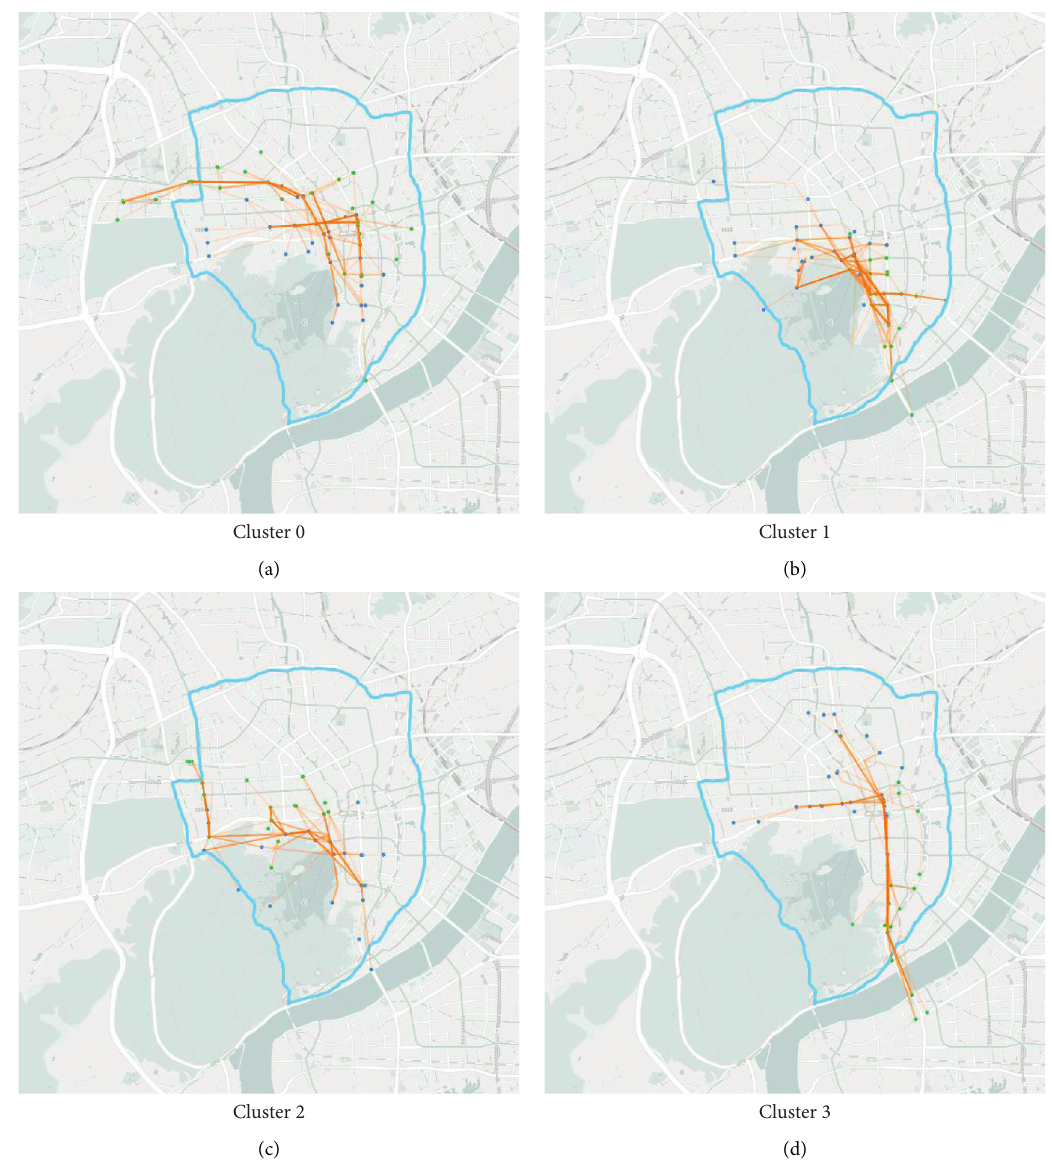
Figure 6: Visualization results of the first four clusters during the morning peak hours on June 15 based on the DBSCAN algorithm; the green point denotes the origin point, the blue point denotes the destination point, and the orange line denotes the trajectory. The darker the color of the line, the more the vehicles passing through the trajectory. Clusters are arranged in the descending order of the number of vehicles in them. (a) Cluster 0. (b) Cluster 1. (c) Cluster 2. (d) Cluster